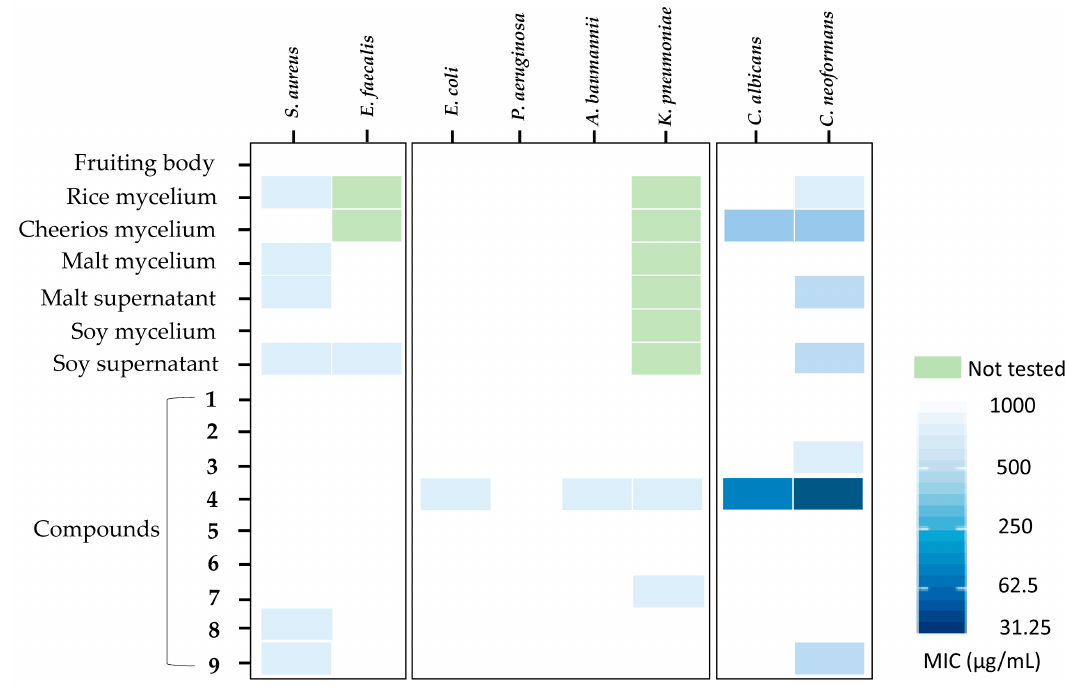
Figure 2. Antimicrobial activity of Hericium sp. WBSP8 extracts and compounds 1 – 9 against a panel of eight human microbial pathogens shown as minimal inhibitory concentrations (MIC, μ g/mL).